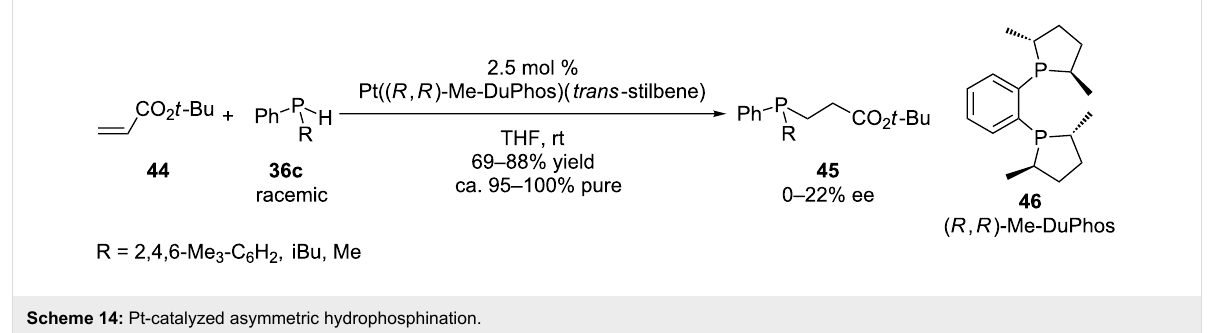
Scheme 14: Pt-catalyzed asymmetric hydrophosphination.